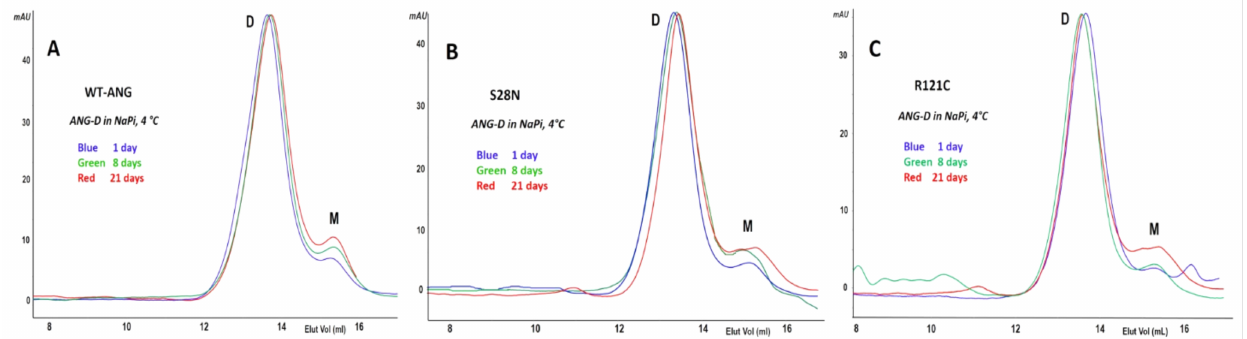
Figure 5. SEC analysis of the intrinsic stability of ANG-D. ( A , B ): wt and S28N-ANG-D after 2 (blue), 10 (green), and 21 (red) days of storage at 0.5 mg/mL in 0.4 M NaPi, pH 6.7, at 4 ◦ C; ( C ): wt- and S28N-ANG-D (blue and red, respectively) after 48 h of storage at RT in 0.10 M sodium acetate, pH 5.0. M: monomer, D: